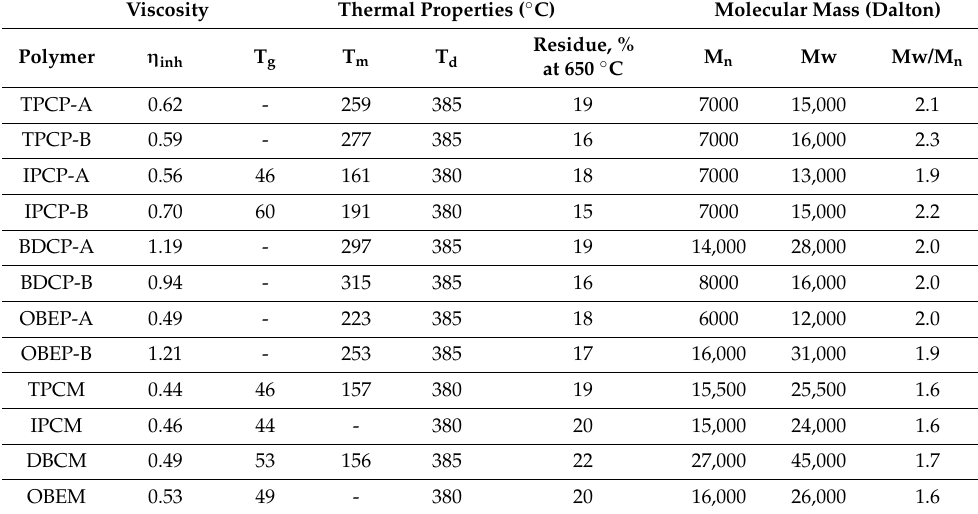
Table 2. Viscosities, thermal properties, molecular mass, and polydispersity of poly(ether amide)s.